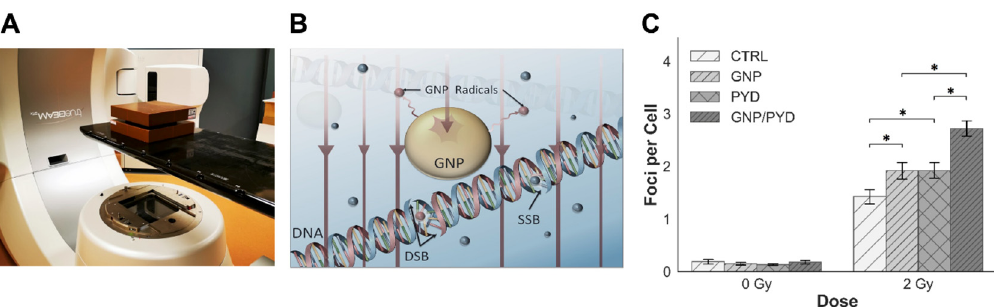
Figure 6. Evaluation of the triple combination of RT/GNP/PYD. ( A ) Linear accelerator set-up used for the radiation treatment of samples. ( B ) Schematic diagram highlighting the enhancement of DNA damage due to the increased presence of radicals (marked in red) in the presence of GNPs during RT. ( C ) Quantitative assessment of DNA DSBs 24 h post irradiation with dose of 2 Gy using 53BP1 as a marker in HeLa cells. Cells were dosed with GNPs and PYD at a concentration of 7.5 µg/mL and 500 nM, respectively. * indicates 0.01 < p < 0.05.